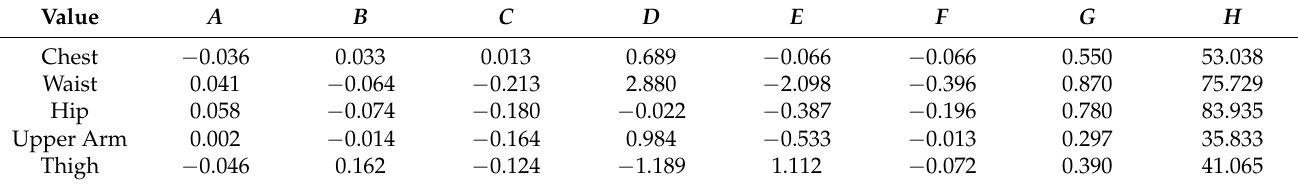
Table 10. Coefficient values for the multiple linear regression of postpartum